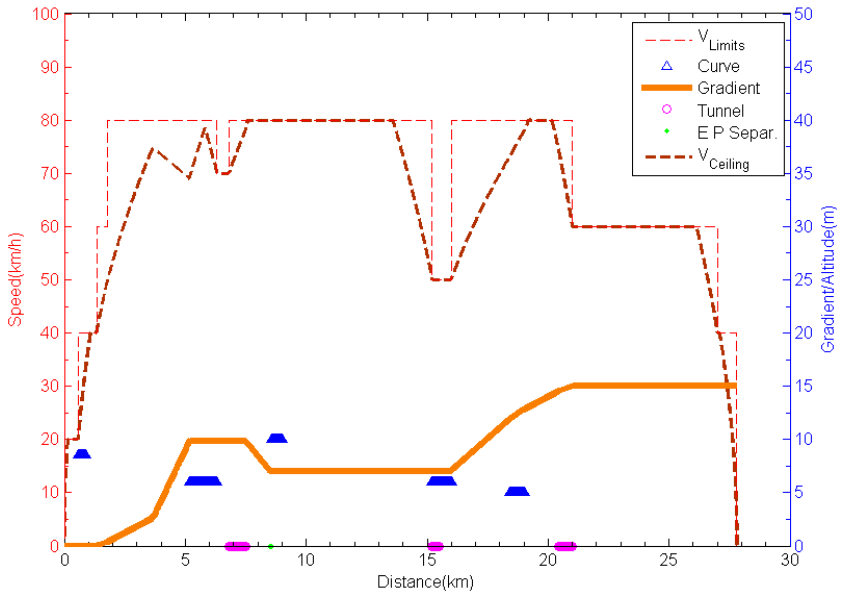
Figure 11. Speed ceiling profile diagram of a test line.